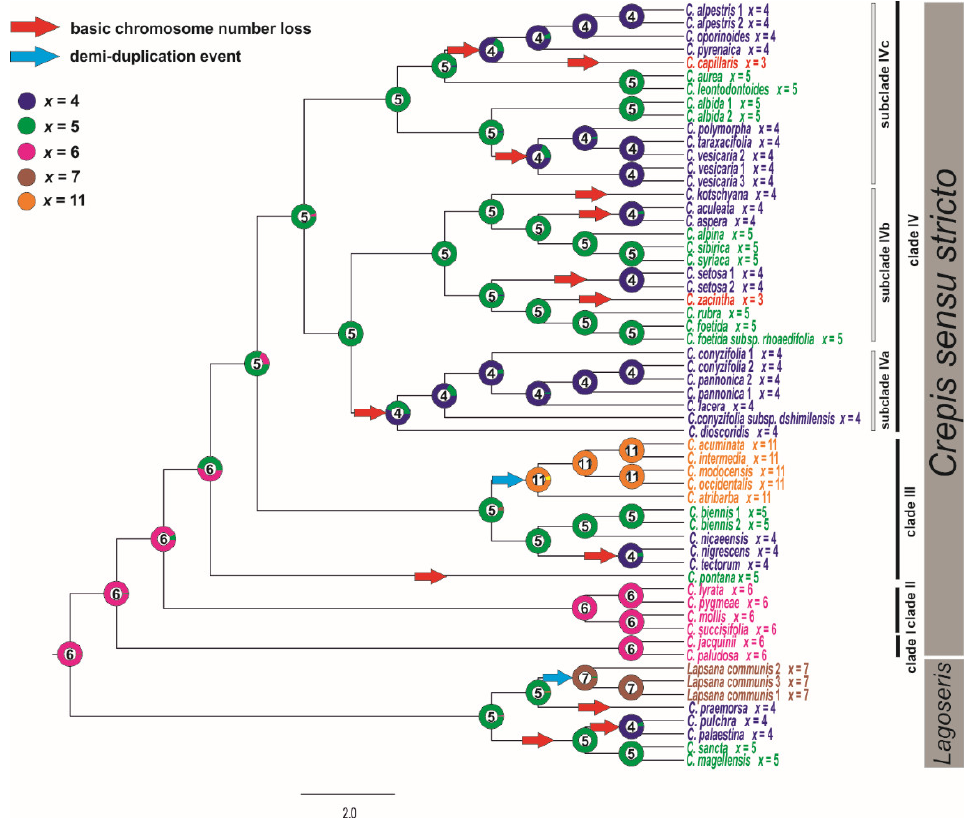
Figure 4. Ancestral character state reconstruction of the chromosome base numbers of the analysed species of Crepis s.l. The chromosome base numbers have been mapped on the ML tree of concatenated cpDNA sequences using the maximum likelihood method implemented in ChromEvol 2.0 software [45]. The tree was rooted with Picris hieracioides , Lactuca serriola , and Sonchus oleraceus.